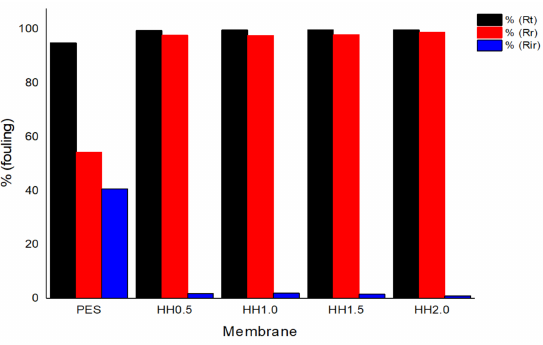
Figure 6. Comparison between total fouling and reversible and irreversible